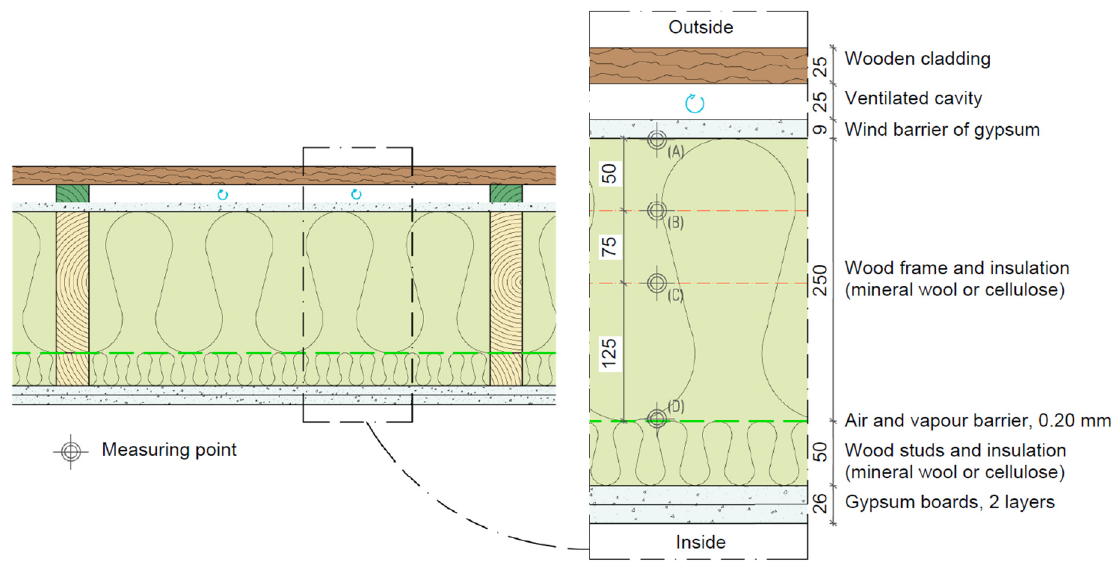
Figure 1. Vertical section of the exterior wood-frame wall. Measuring points A to D are located in the thermal insulation, starting with point A just behind the wind barrier on the exterior side and with point D just behind the vapour barrier facing outside.